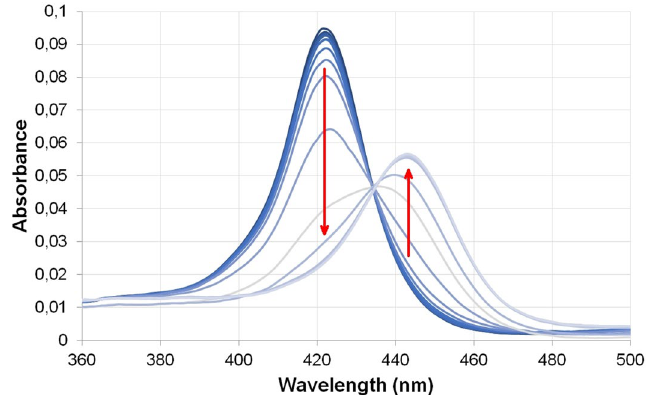
Figure 6. Absorbance spectra of TMPyP4 (0.5 μM) and HepB at concentrations from 10 nM to 10 μM. In 100 mM K-phosphate buffer pH 7.4. Arrows show the spectral changes due to increasing HepB concentration. The curves are corrected for the dilution of TMPyP4.